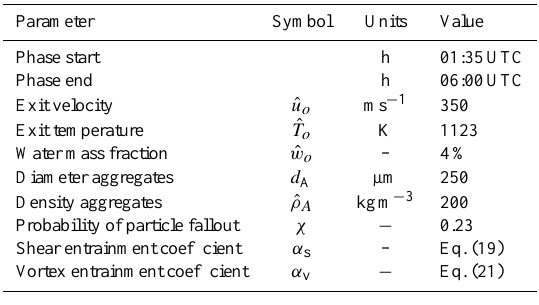
Table 4. Input values for the El Chichón Phase-B simulation. Values for specific heat of water vapour, liquid water, ice, pyroclasts and air at constant pressure are assigned to defaults of 1900, 4200, 2000, 1600 and 1000Jkg − 1 K − 1 .